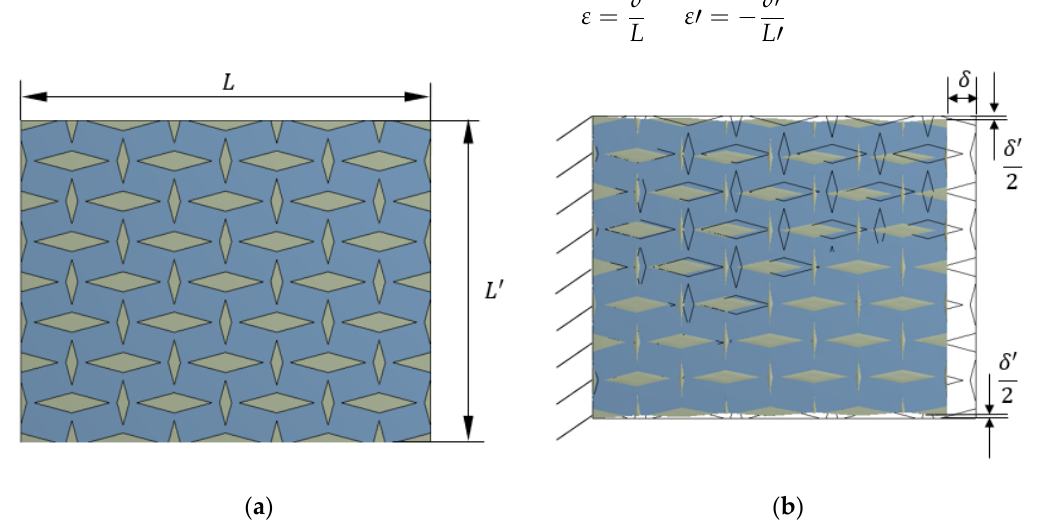
Figure 4. ( a ) Architected plate with rotating rigid units; ( b ) illustration of the NPR effect.